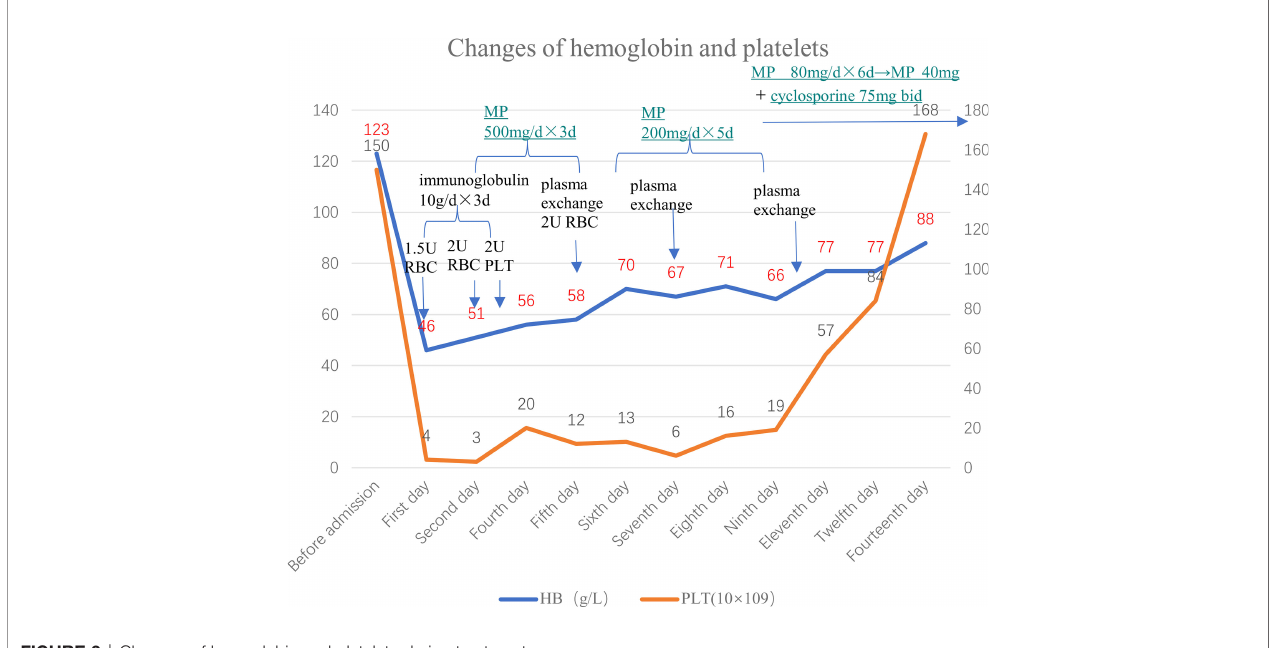
FIGURE 3 | Changes of hemoglobin and platelets during treatment.